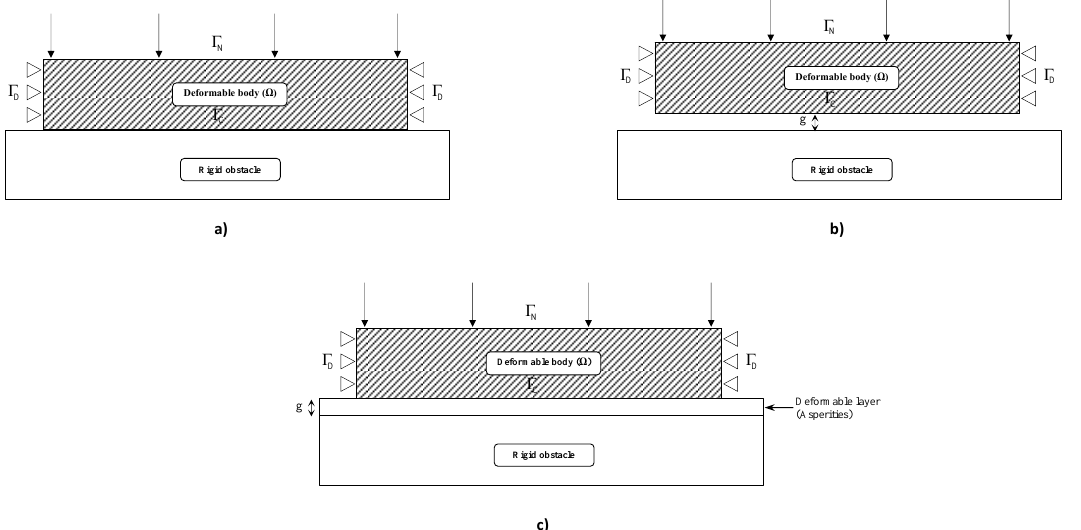
Figure 1. Physical setting: ( a ) contact with a rigid obstacle without gap; ( b ) contact with a rigid obstacle with gap; ( c ) contact with a rigid obstacle covered by a deformable layer.